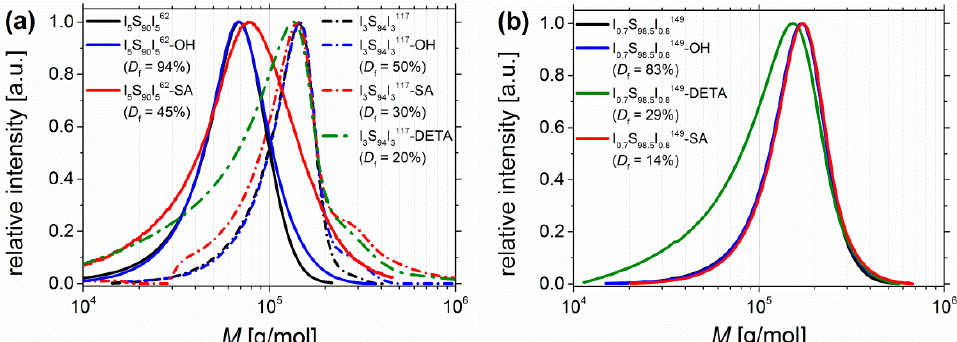
Figure 9. SEC curves of ( a ) I 5 S 90 I 562 (lined) and I 3 S 94 I 3117 (dashed), and of ( b ) I 0.7 S 98.5 I 0.8149 before functionalization (black), after hydroxylation (blue), after DETA ‐ functionalization (green), and after carboxylation (red). I 5 S 90 I 562 ‐ DETA was not soluble at 30 °C, consequently no SEC was done. Calibration of SEC was done with polystyrene standards.